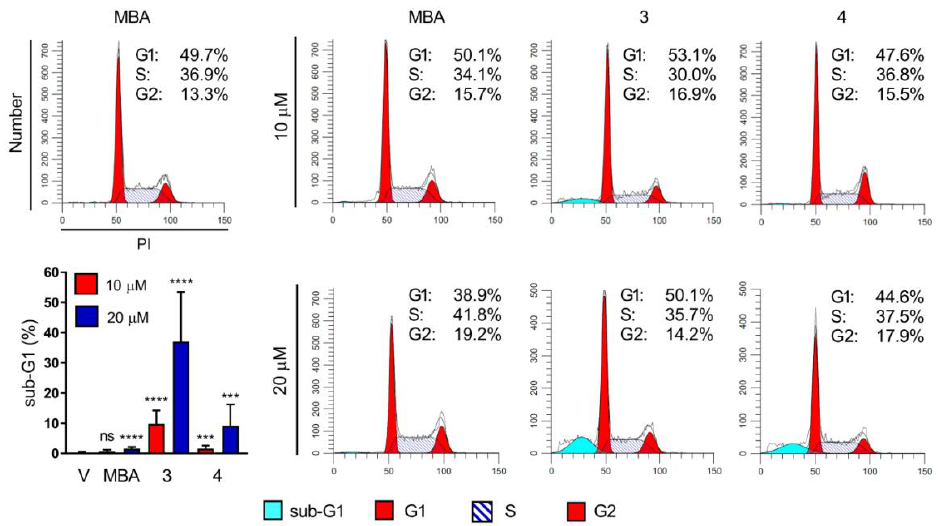
Figure 2. Effect of MBA and its silyl derivatives 3b and 3c on cell cycle in HCT 116 cells after 24 h exposure; Representative cytograms (with percentage of cells in cell cycle phases) from one of at least two independent experiments are shown; quantification of sub-G1 cell percentage is shown (left bottom column plot); ns — not significant, *** p < 0.005, **** p < 0.0005 . The concentration-dependent accumulation of cells in the sub-G1 peak after treat- ment with compounds 3b and 3c suggests that these compounds may exert their